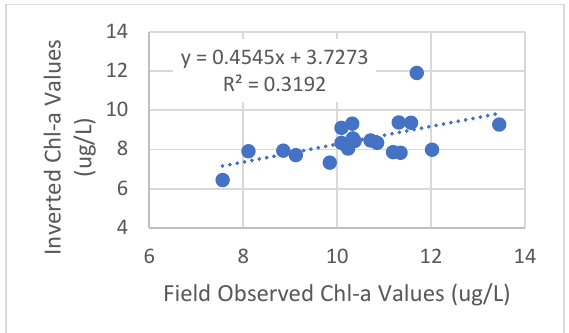
Figure 9. Assessment of Inverted and Field Observed Chlorophyll-a